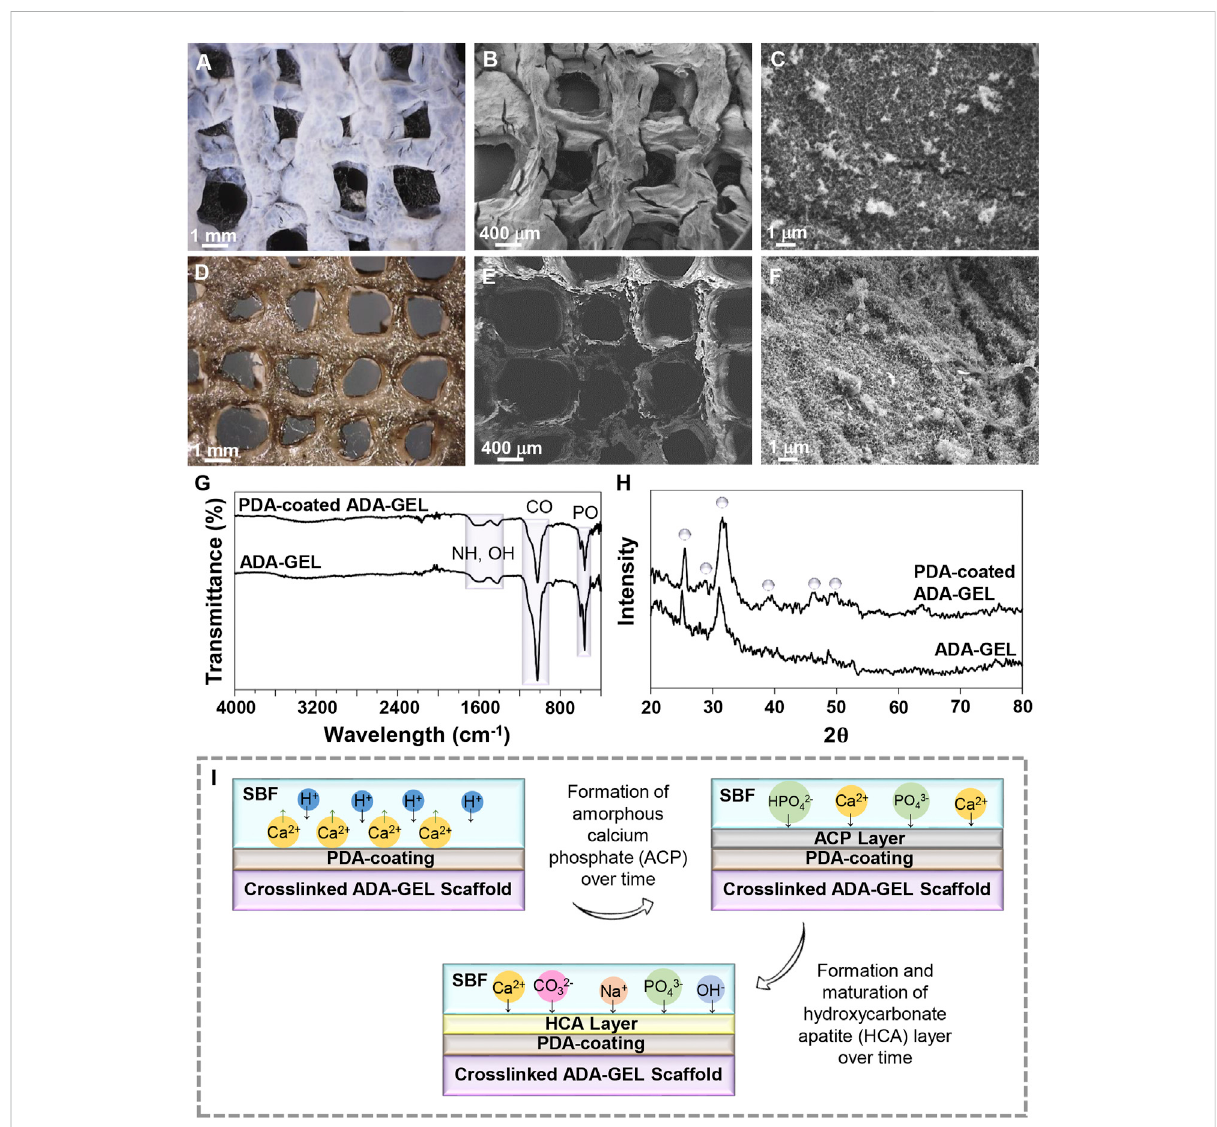
FIGURE 5 In-vitro bioactivity of the scaffolds. (A,D) Light microscope images and (B,C,E,F) FE-SEM images of (A – C) ADA-GEL and (D – F) PDA-coated ADA-GEL scaffolds after 18 days of immersion in the SBF solution. (G) FTIR spectrum and (H) XRD spectrum of ADA-GEL and PDA-coated ADA-GEL after biomineralization of HA-like layers. (I) Schematic illustration of the HA formation mechanism on